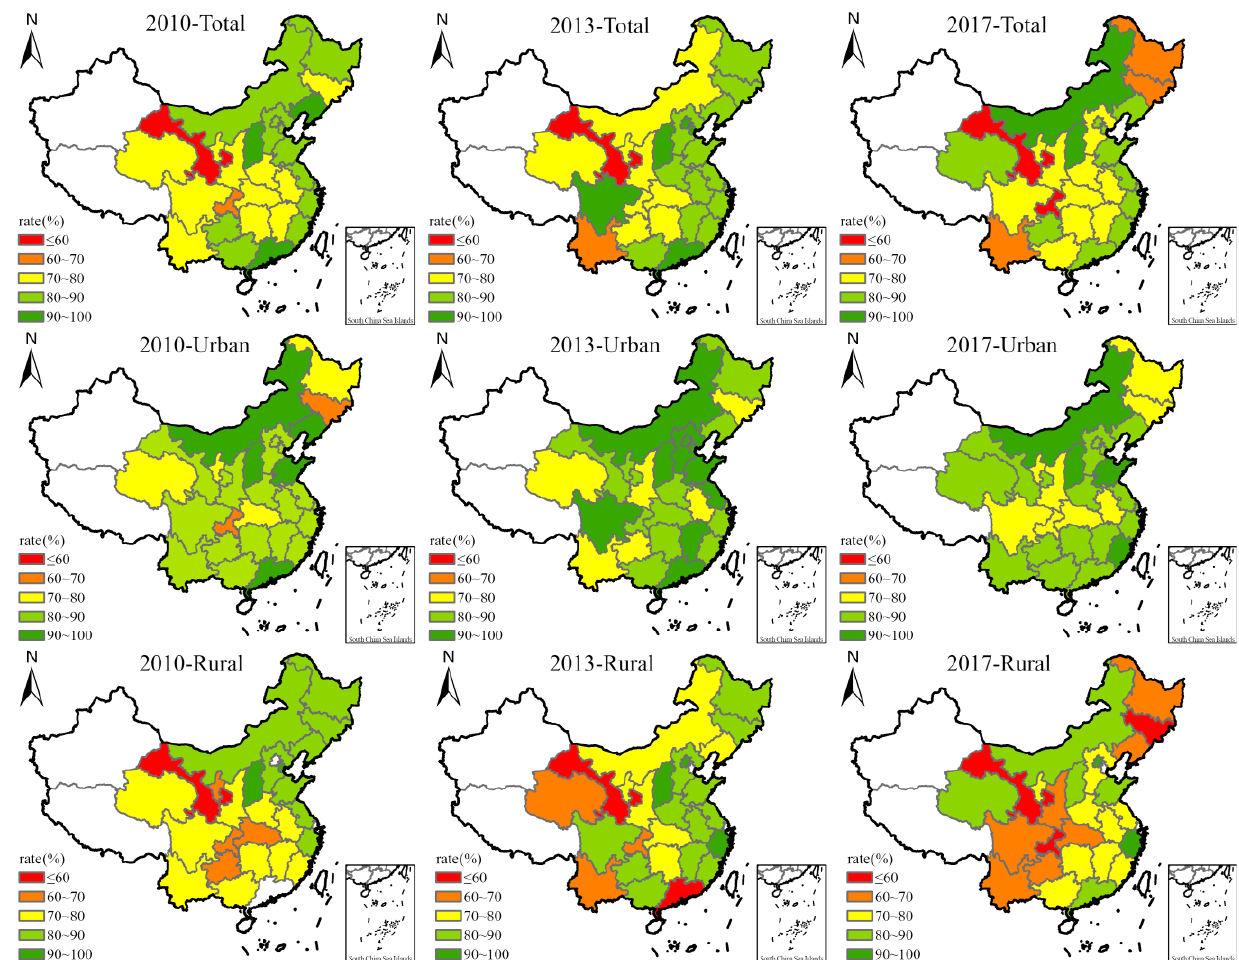
Figure 1. Spatio-temporal patterns of the proportion of healthy people.